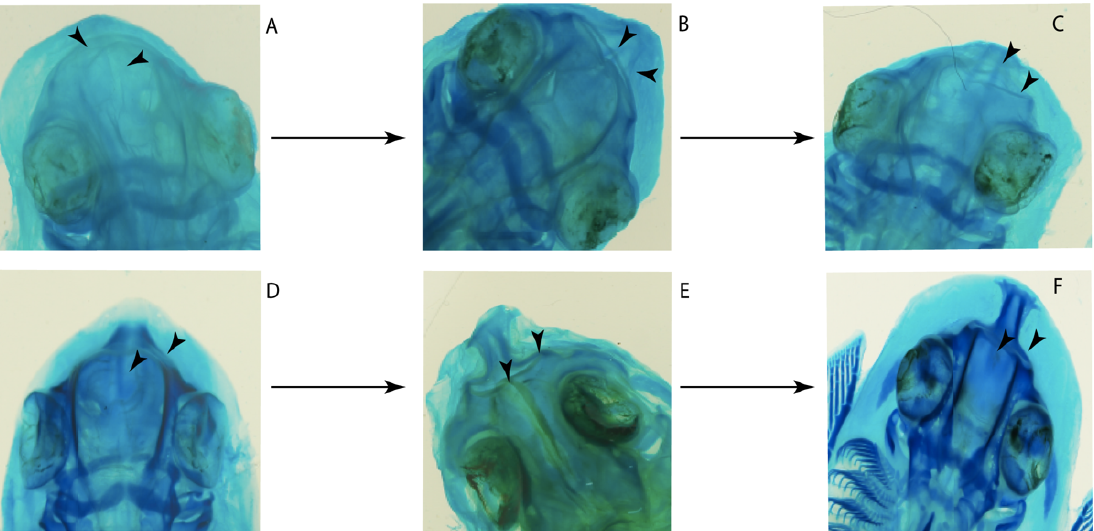
Figure 4. Generalization of the development of the rostral cartilages in Neoselachii using Zapteryx brevirostris (UREJ, unpublished data). ( A – F ) Letter sequences follow the order of the morphological development; arrowheads show the regions involved in the